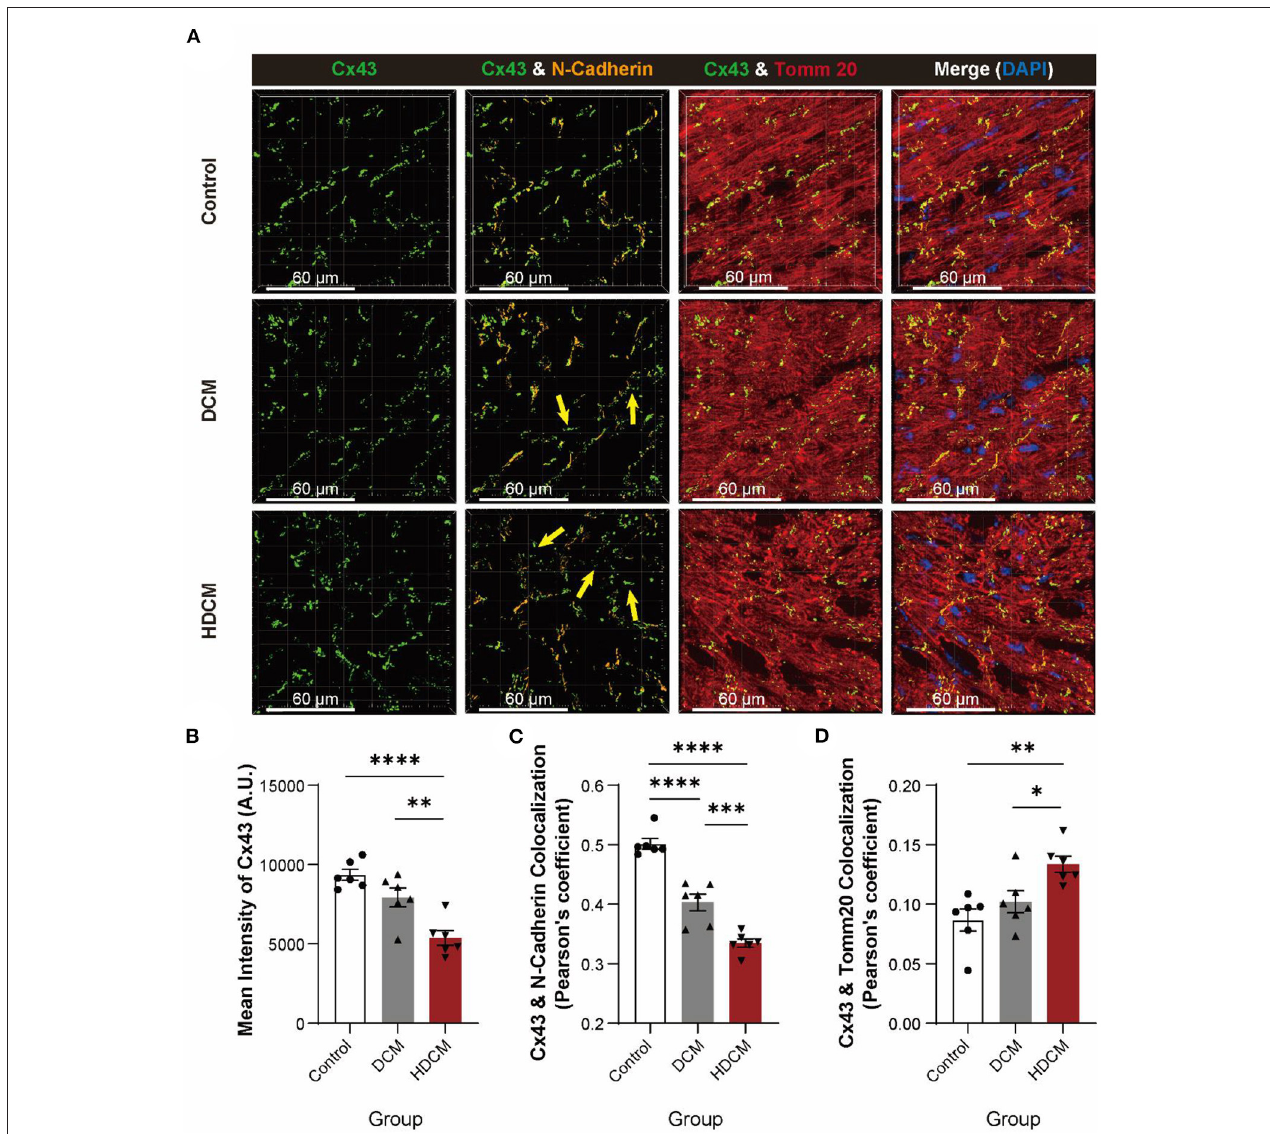
FIGURE 4 | HDCM mice exhibit a worse degradation and displacement of Cx43. (A) Immunofluorescent staining of Cx43, N-cadherin, and Tomm20 in myocardial tissue of control, DCM, and HDCM mice (yellow arrow: aberrant Cx43 in mitochondria, n = 5 mice per group; scale bars, 60 µ m). (B–D) Analysis of mean intensity of Cx43 [ (B) , n = 6 field views per group], colocalization of Cx43 and N-cadherin [ (C) , n = 6 field views per group], and colocalization of Cx43 and Tomm20 [ (D) , n = 6 field views per group]. Data are shown as mean ± SEM. One-way ANOVA test was used. * P < 0.05, ** P < 0.01, *** P < 0.001, **** P <